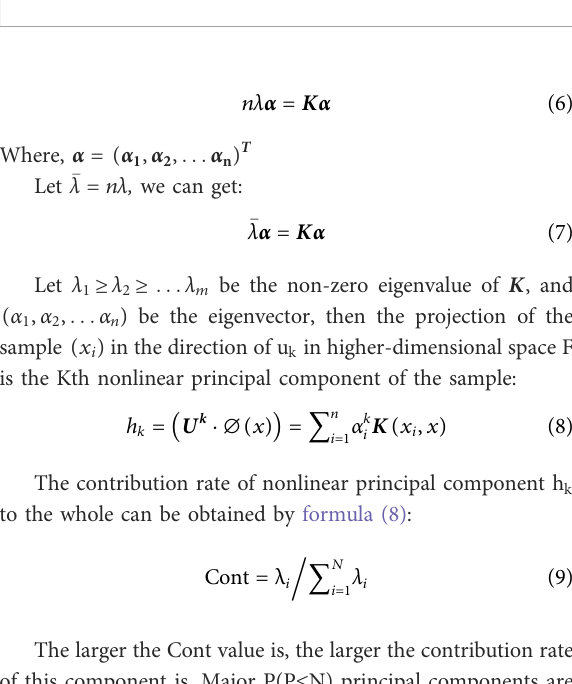
FIGURE 3 Deep residual shrinkage network structure